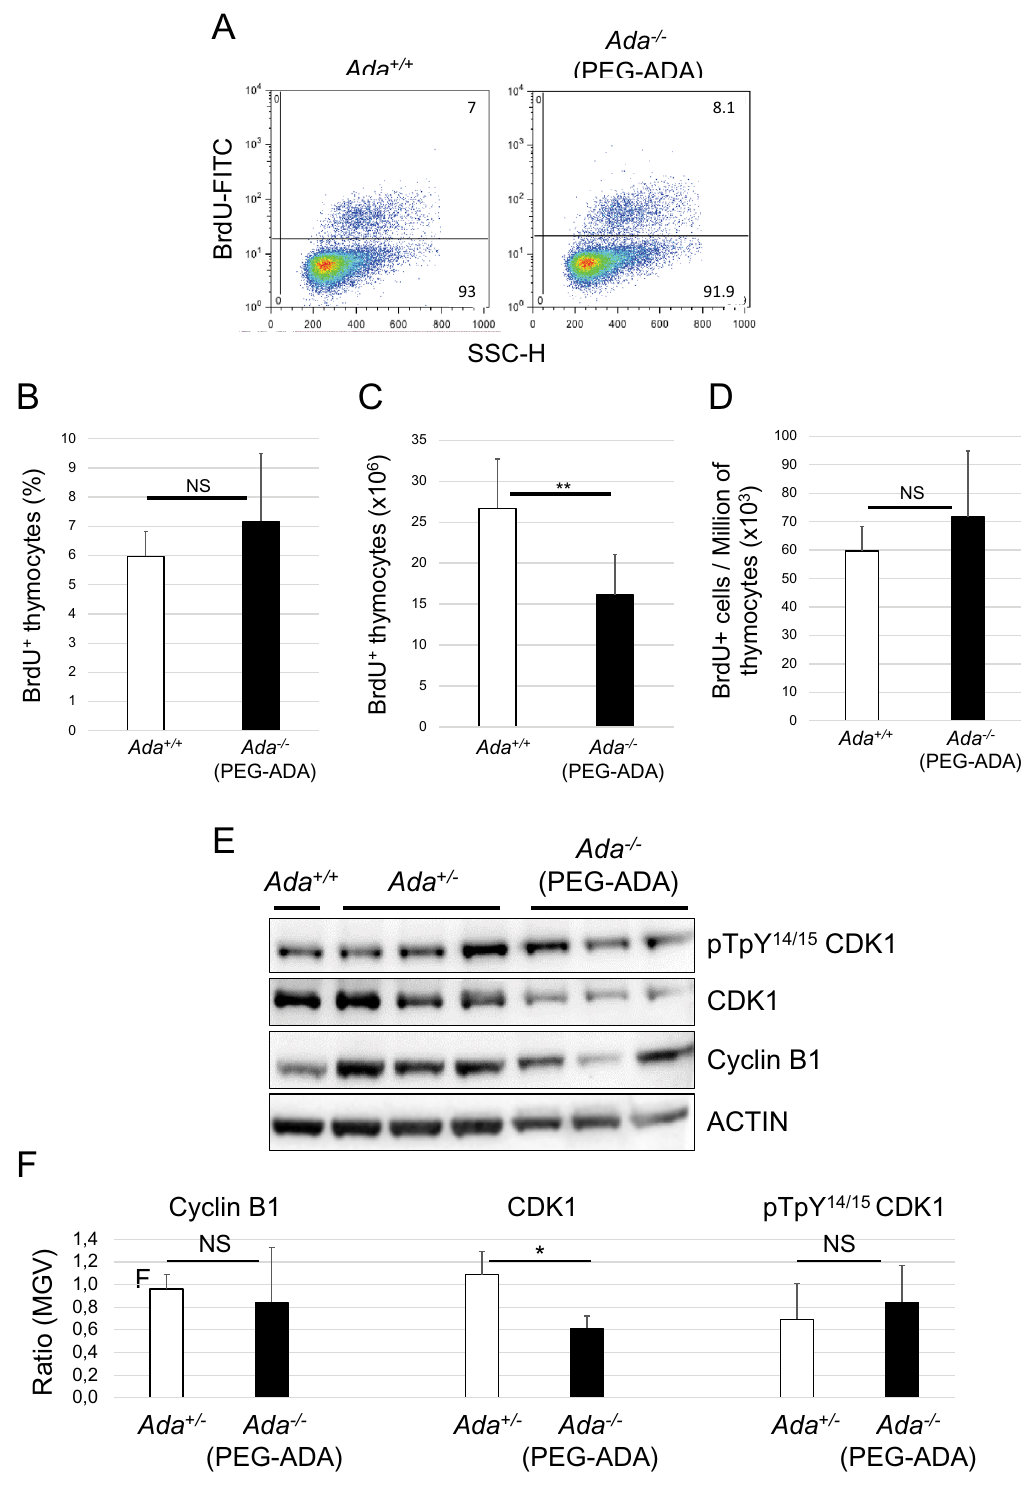
Figure 7. Ado accumulation does not interfere with thymocytes proliferation. ( A ) FACS plots of proliferating thymocytes (BrdU + ) from control ( Ada + / + ) and 3-week-PEG-ADA-treated Ada −/− mice. Bar graphs representing percentages ( B ), absolute ( C ) and relative ( D ) numbers of BrdU + thymocytes shown in (A) (n = 6, 6). ( E ) Western blot analysis of protein lysates of thymocytes shown in (A). Anti-ACTIN stain was used as protein loading control. Full-length blots are presented in Supplementary Fig. 12. ( F ) ImageJ quantification of protein bands from Western blot film shown in (E). MGV = mean gray value. * P < 0.05, ** P < 0.01 and *** P < 0.001. NS = statistically not